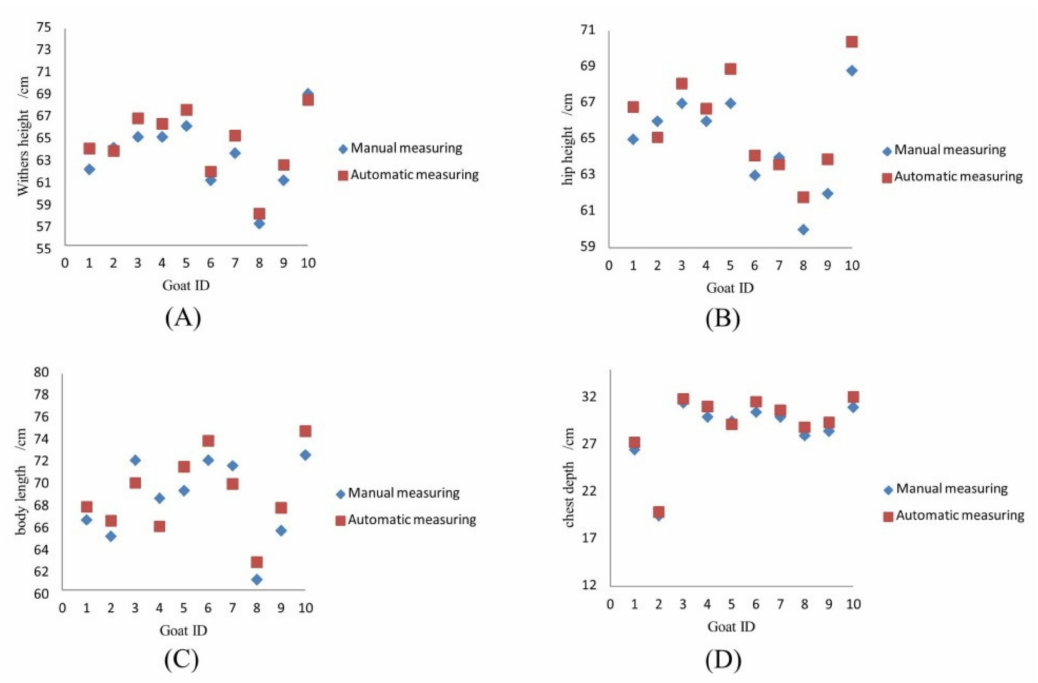
Figure 16. Comparison of manual measurement and the proposed method for the four different goat body parameters: ( A ) Withers height, ( B ) hip height, ( C ) body length and ( D ) chest